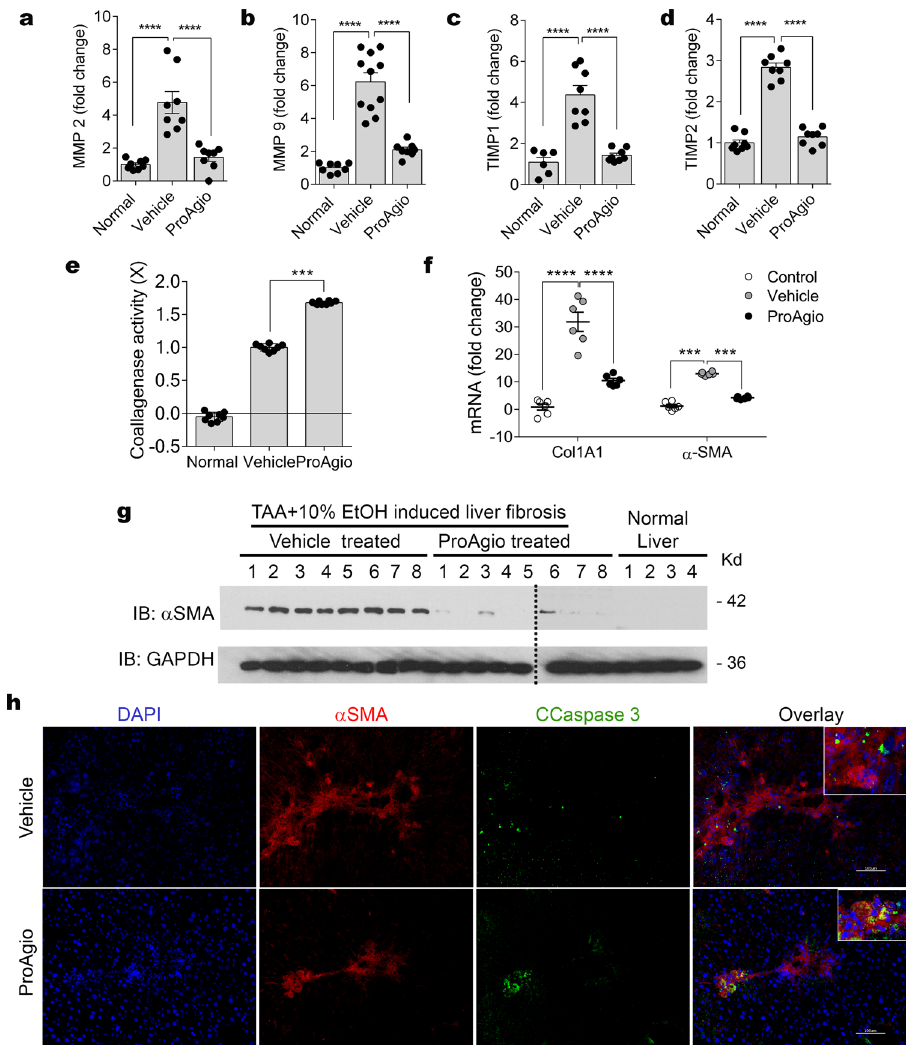
Fig. 3 ProAgio changes collagenase activity and decreases collagen cross-links in fi brotic liver. Levels of MMP2 ( a ), MMP9 ( b ), TIMP2 ( c ), and TIMP1 ( d ) in extracts of liver tissues from mice treated with indicated agents were measured by ELISA, and are presented as fold changes compared with that of non- fi brotic mice. e Collagenase activity of extracts prepared from livers of mice treated by the indicated agents was measured using Colorimetric Collagenase Activity Assay Kit. Collagenase activity is presented as fold changes using the extracts from livers of normal healthy mice as reference. f RT- PCR analyses of α -SMA and collagen 1 (Col1A1) mRNA levels in liver extracts of animals under indicated treatment. The mRNA levels are presented as fold changes comparing to the control (non- fi brotic and untreated animals) as reference. g Immunoblot analyses of α -SMA (IB: α -SMA) levels in liver extracts of the individual mice (numbered on top of picture) under indicated treatment. Immunoblot of GAPDH (IB: GAPDH) is a loading control. h Representative images of immuno fl uorescence (IF) staining of α -SMA (Red) and cleaved caspase-3 (green) and the overlay of co-stains (Yellow) of liver sections from mice treated with indicated agents. Scale bars show 100 µ m. Error bars in a – e and f are standard deviations of measurements of 10 mice. Normal in a – e and g and control in f are the mice without fi brosis induction and treatment. *** P < 0.001, **** P <